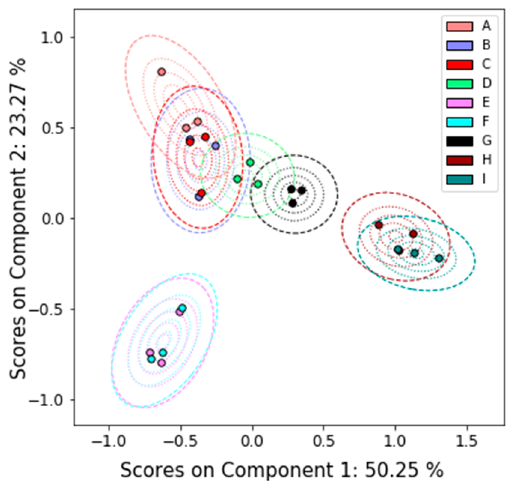
Figure 5. PCA results with uncertainty analysis on the ILS’s LC-MS data using virtual peak lists. Lab 4 is excluded from this analysis because of the relatively low number of features. Note that each sample (A–I) has three scores, one for each lab.